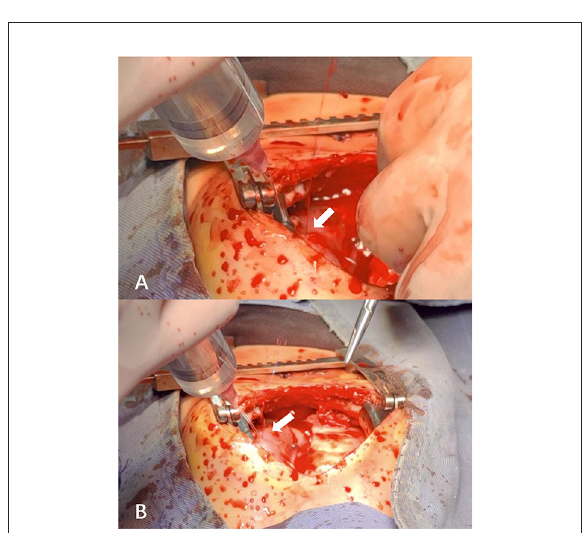
FIGURE2 (A,B) Active bleeding from the anterior right ventricular branch (a branch of the right coronary artery) observed at different angles in the same operative field during exploratory